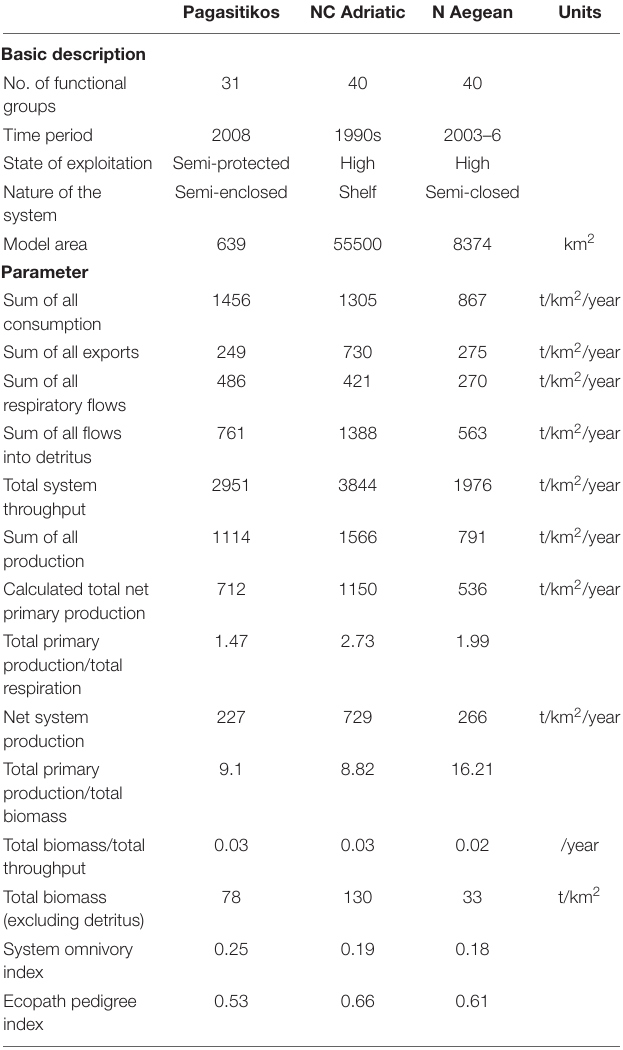
TABLE 3 | Statistics, flows, and ecological indicators for Pagasitikos Gulf in comparison to models from other Mediterranean areas (NC Adriatic: Coll et al., 2007; N Aegean: Tsagarakis et al., 2010). Basic descriptive characteristics of the models are also